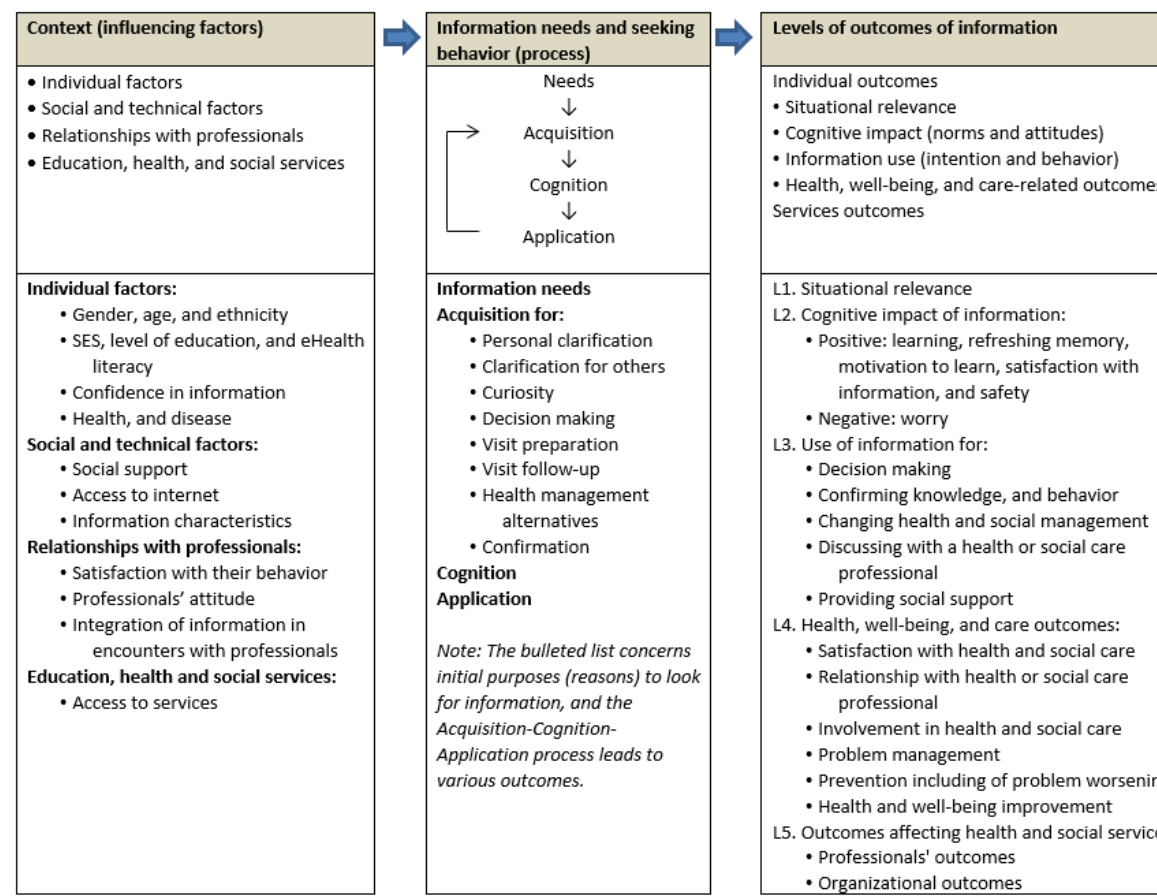
Figure 1. Outcomes of web-based parenting information: conceptual framework. SES: socioeconomic